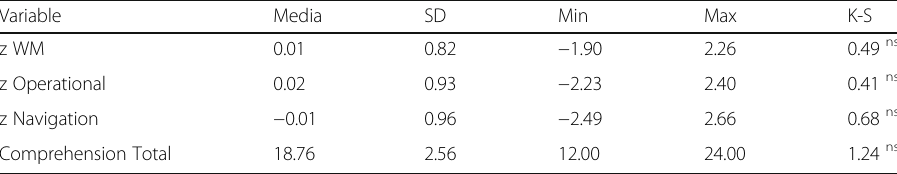
Table 4 Descriptive statistics for comprehension, WM and internet skills